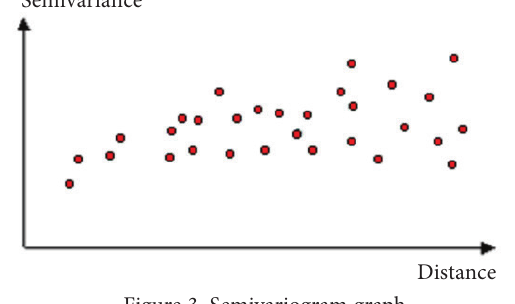
Figure 3. Semivariogram graph